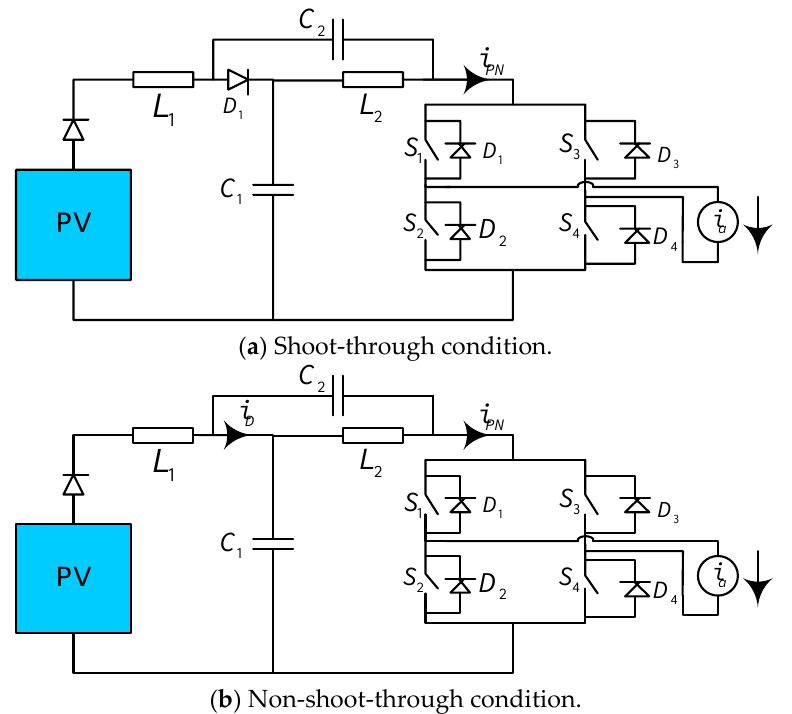
Figure 18. qZSI’s equivalent circuit.